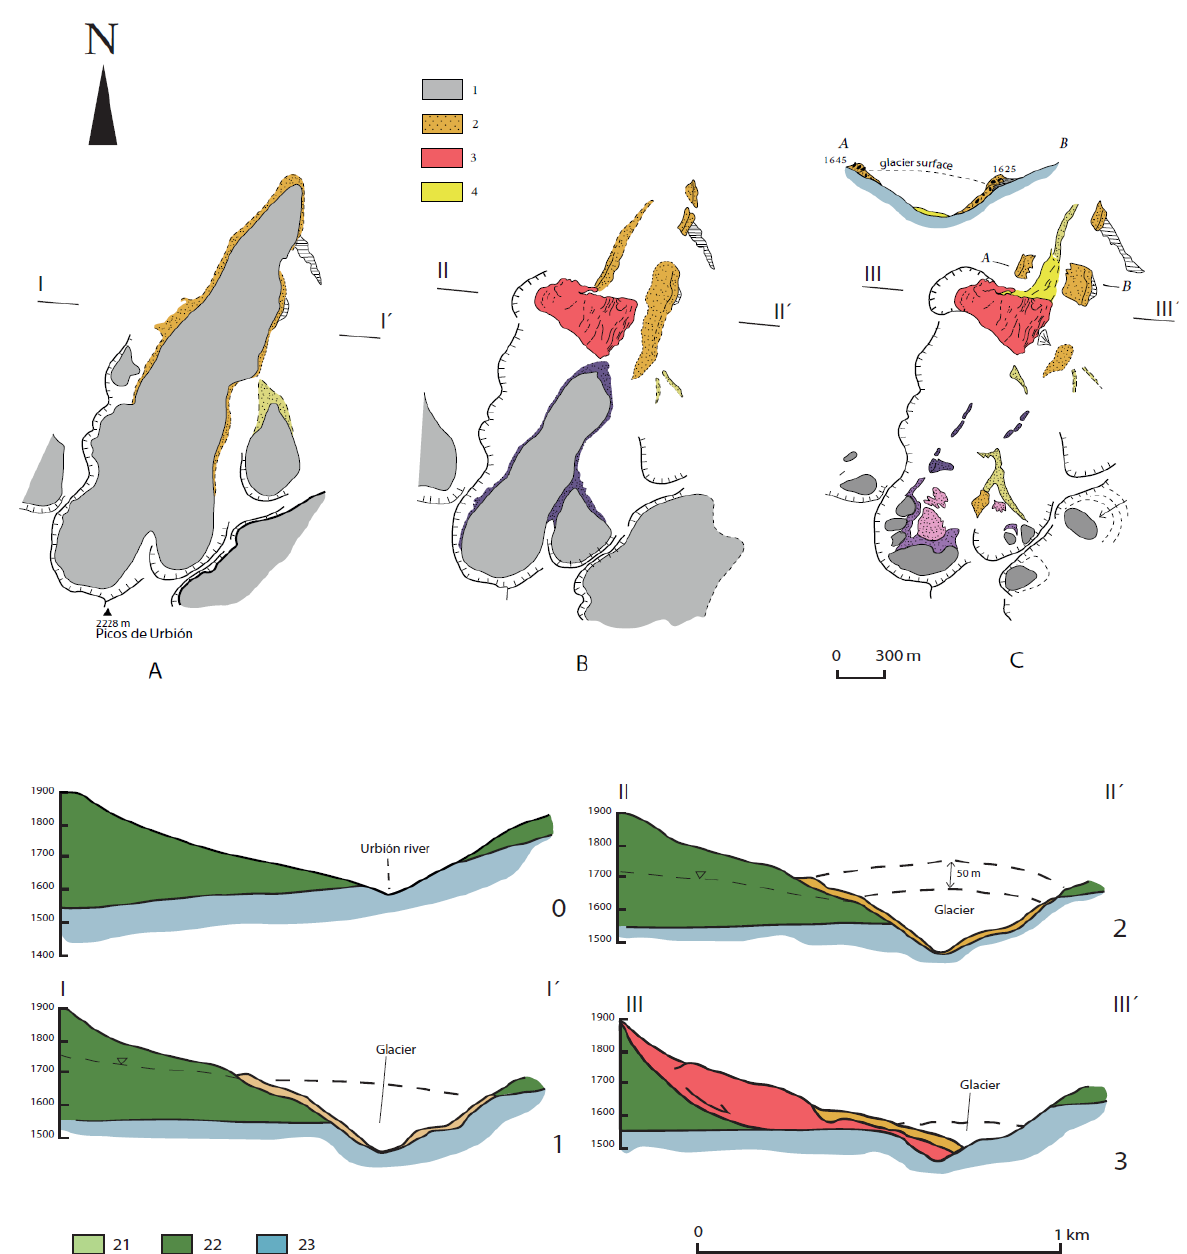
Figure 9. Steps followed in the formation of the landslide: Above: ( A ) Maximum advance and extent of the glacier, according to lateral moraines; ( B ) Retreat of the glacier to the rocky step and formation of the landslide; ( C ) Follow the retreat of the glacier. Formation of the alluvial fan induced by the landslide, eroding the head scarp. 1. Glacier; 2. Lateral moraines of glacial maximum; 3. Landslide; 4. Alluvial fan induced by landslide. Bottom: Profiles showing the previous phases: (0). Pre-glacial valley; (1). Maximum advance and excavation of the glacier; (2). Retreat of the glacier and decrease in the thickness of the tongue, leaving the moraines outcropping; (3). Landslide of the left slope with the lateral moraine. (21) Sandstones and lutites; (22) Lutites and clays; (23)